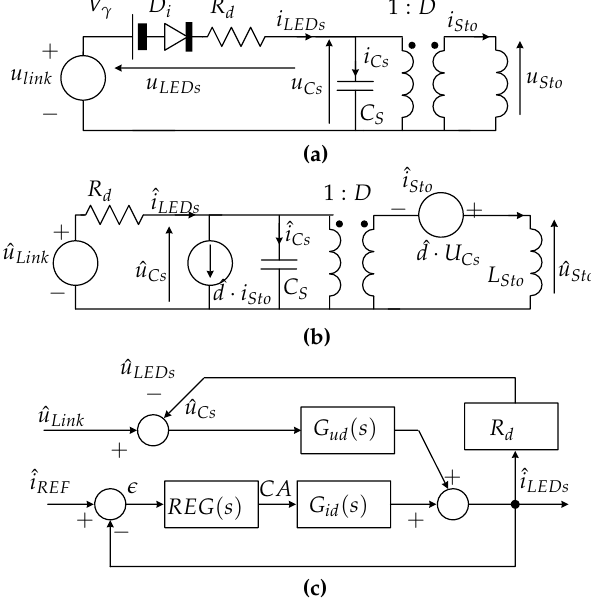
Figure 9. LF equivalent circuit of proposed